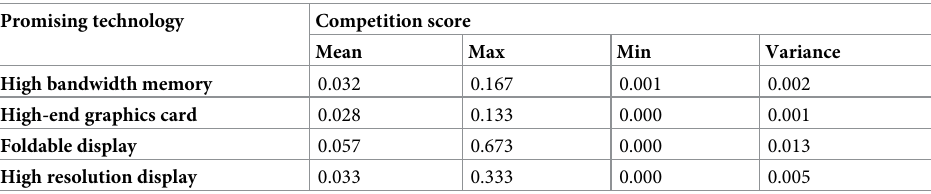
Table 6. Descriptive statistics of competition